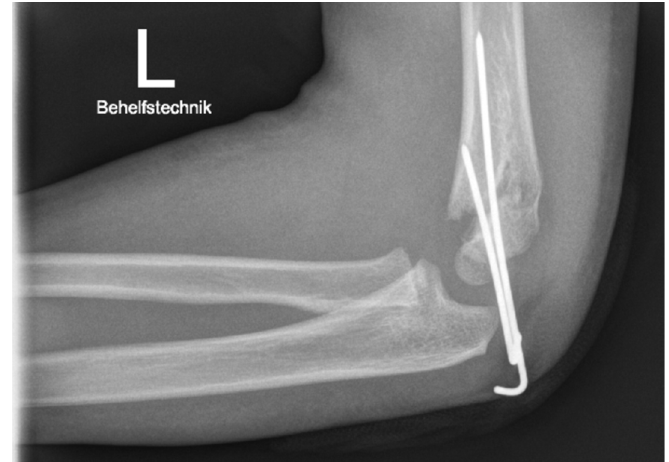
Figure 3. Postoperative radiograph of a rotational spur in the lateral view of a four-year-old patient after Gartland type 3 fracture and treatment by PCP.